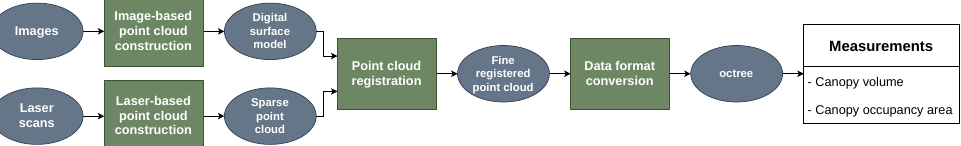
Figure 5. Data processing pipeline used to generate 3D models from raw data and further canopy measurements. The green rectangles correspond to pipeline processing stages; the blue ellipses represent data, and the list at the end contains the measurements